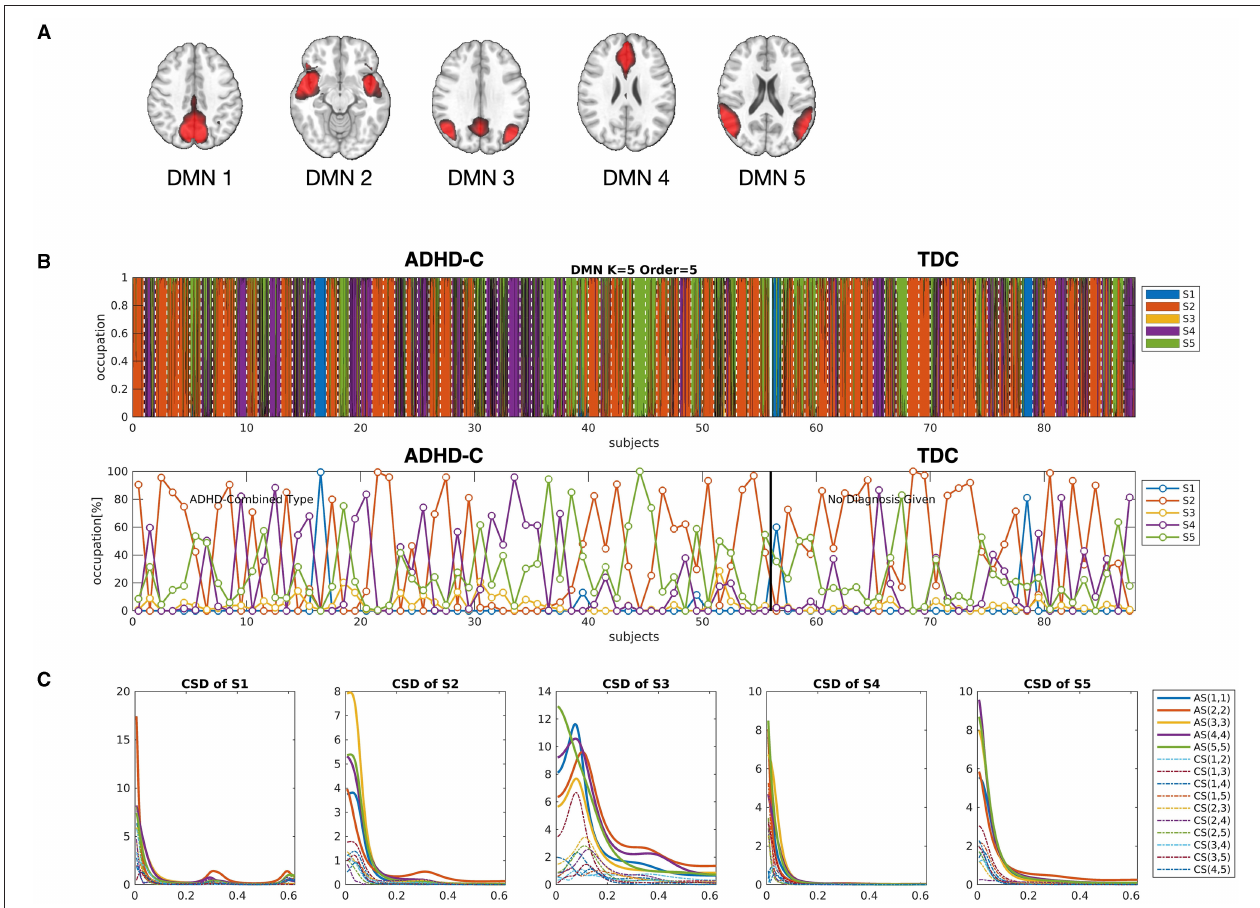
FIGURE 4 | (A) The five independent components were used as nodes for the DMN network in the current study. (B) The occupation indices of five major cross-spectral density (CSD) states for all individuals, derived from HMM-MAR ( K = 5 and order = 5), were concatenated and colored according to the amount of occupation portion of each state at each window. The states for individuals (21 windows per individual) were sectioned by white dotted lines. The lower panel of (B) indicates the occupation indices of all the states in each individual. (C) The auto-spectra (AS) and cross-spectra (CS) densities for the five major states were displayed. Among the five major states, S2, S4, and S5 were shared by all